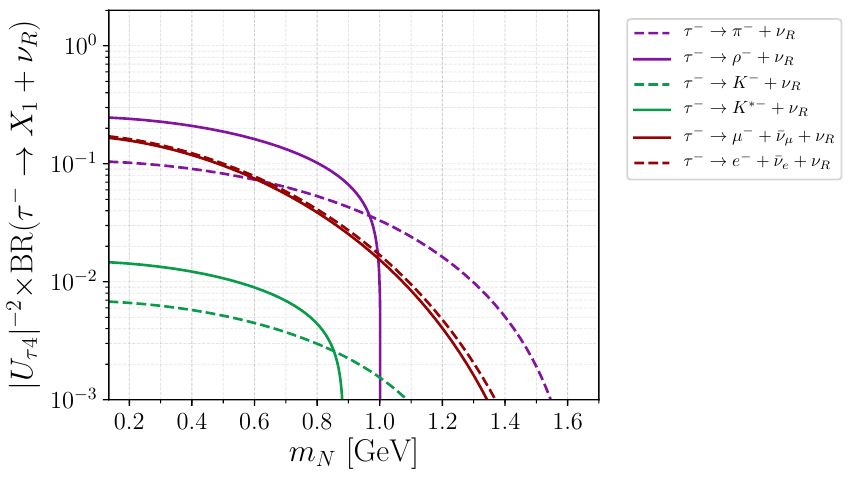
Figure 1 . Tau decay branching ratios into a sterile neutrino in the minimal scenario.